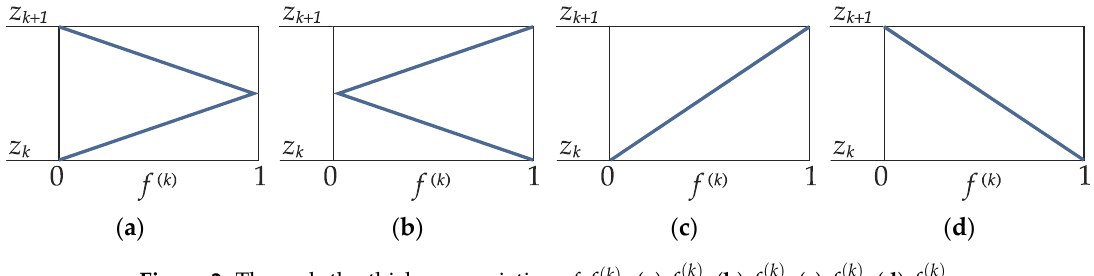
( k ) ( k ) ( k ) ( k ) ; ( b ) f ; ( c ) f ; ( d ) f X V O A